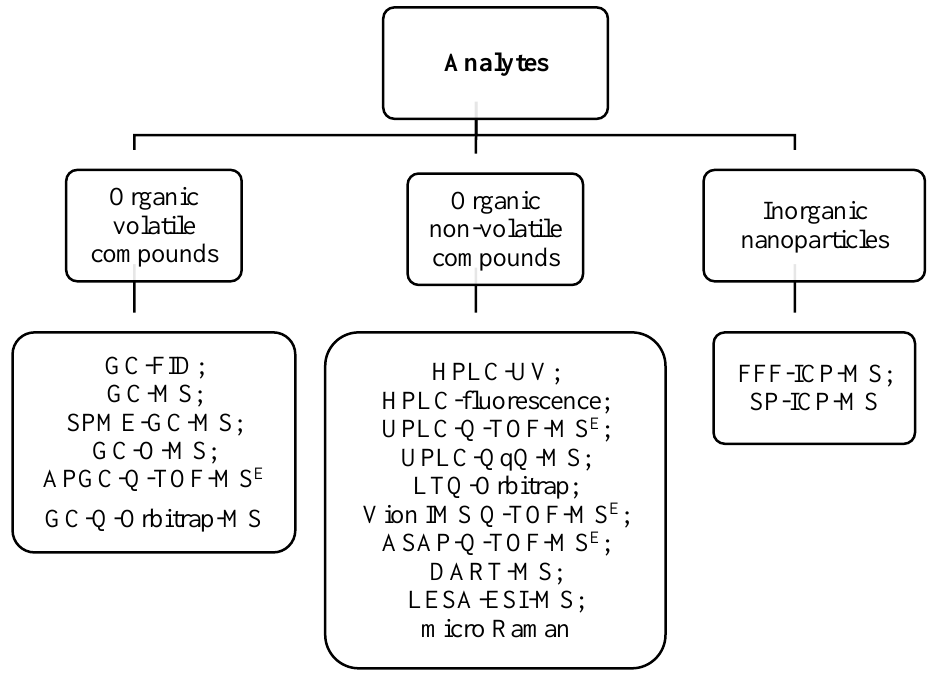
Figure 1 . Dependency diagram of analytes from food contact materials and example of analytical Figure 1. Dependency diagram of analytes from food contact materials and example of methods that can be applied for their analysis. GC-MS — gas chromatography coupled to mass analytical methods that can be applied for their analysis. GC-MS—gas spectrometry; GC-O-MS — gas chromatography with olfactometry coupled to MS detector; APGC-Q- TOF-MS E — atmospheric pressure gas chromatography coupled to quadrupole-time of flight mass spectrometry Elevated Energy ; GC-Q-Orbitrap-MS — gas chromatography coupled to quadrupole-Orbitrap mass spectrometry; LTQ-Orbitrap — hybrid linear ion trap-high resolution mass spectrometry combined with mass spectrometry; Vion IMS Q-TOF-MS E — Vion ion mobility quadruple time-of- flight with MS E technology; ASAP-Q-TOF-MS — atmospheric solids analysis probe coupled to quadruple time-of-flight with MS E technology; DART-MS — direct analysis in-real-time coupled to mass detector; LESA-nESI-MS — liquid extraction surface analysis nano-electrospray mass